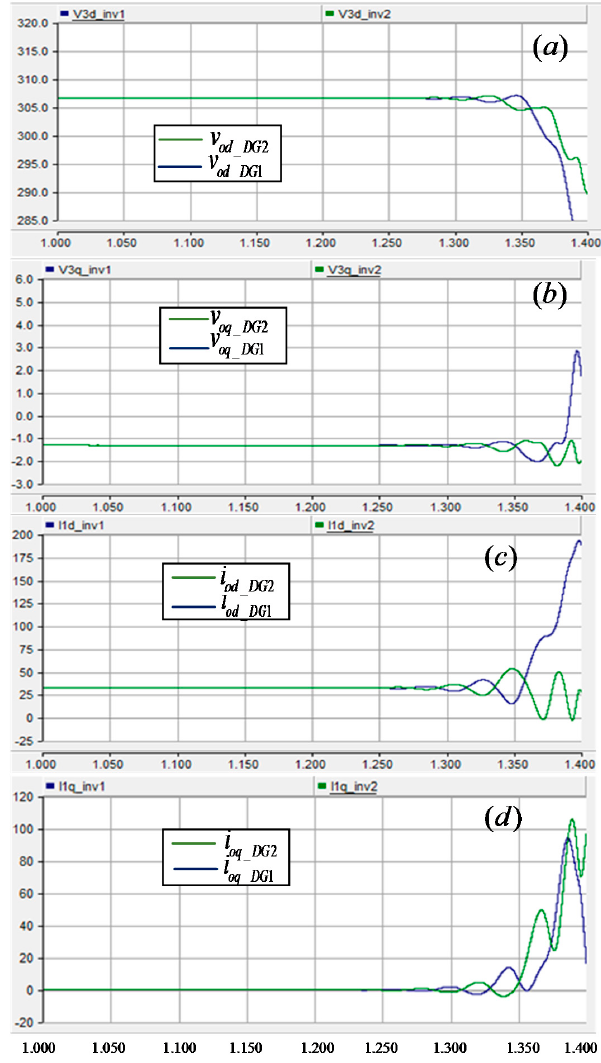
Figure 19. Response of the DG unit with two sets of droop parameters: ( a ) d -axis components of the output voltage, v o ; ( b ) q -axis components of the output voltage, v o ; ( c ) d -axis components of the output current, i o ; and ( d ) q -axis components of the output current, i o